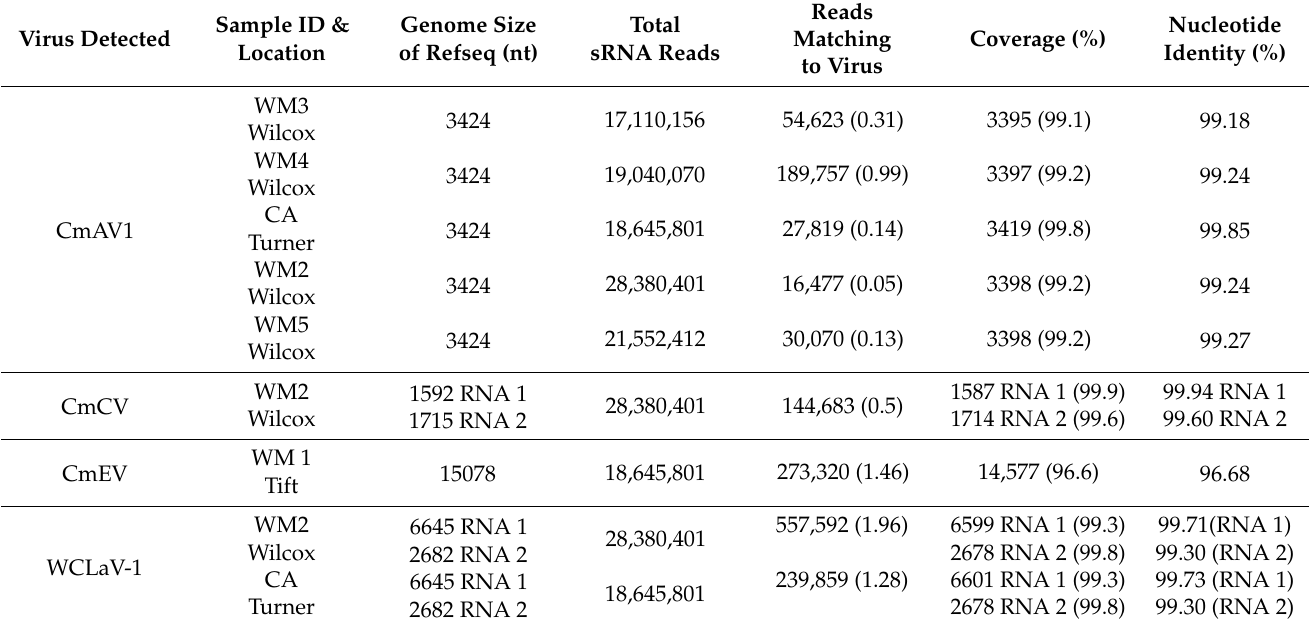
Table 2. Viruses identified in sRNA reads from watermelon and cantaloupe samples collected in spring from Georgia and their